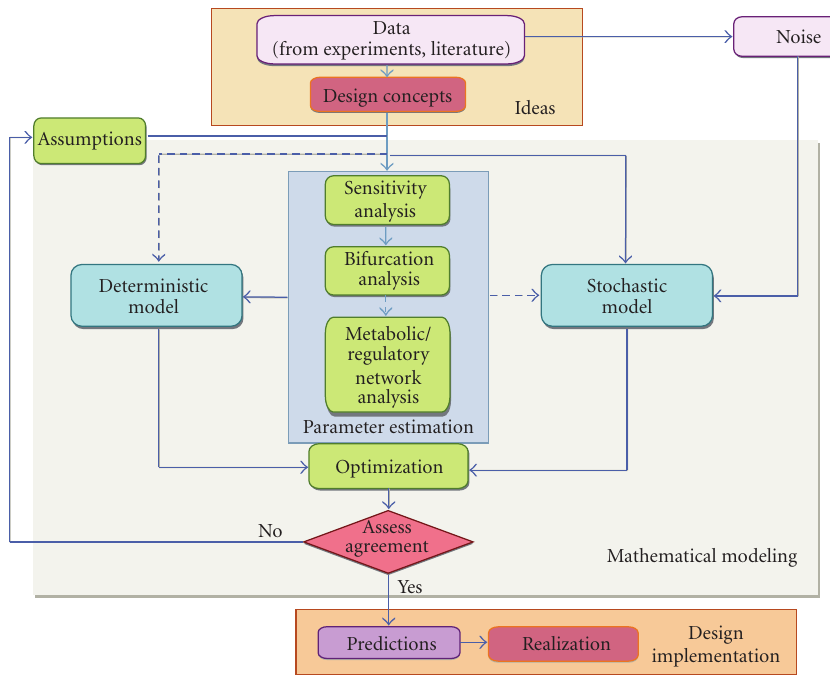
Figure 1: The role of mathematical modeling in synthetic biology. Computer-aided mathematical modeling bridges a design concept to realization in synthetic biology. Solid lines depict typical steps that have to be performed while developing a model; dashed lines depict unusual scenarios or conditions under which the steps shown by the corresponding solid lines are trivial or can be bypassed. A concept or ideas for designing a circuit for a particular function may be inspired by data from experiments or the literature. A mathematical model is then formulated on the basis of certain assumptions. The framework of a model could be deterministic or stochastic. The development of a model generally begins with the estimation of parameters that govern the model; this is a process that involves sensitivity analysis, bifurcation analysis, and, under certain circumstances, metabolic and transcription (regulatory) network analysis. The dashed line from design concepts to deterministic model indicates that, in some cases, parameter estimation is trivial or can be bypassed for this type of model. A stochastic model is developed by employing statistical functions to mimic system dynamics and considering fluctuations in the data. The dashed line from parameter estimation to stochastic model indicates that in some cases, parameter estimation may o ff er information in choosing statistical functions when constructing a stochastic model. Optimization is required for both models and is complete when the model exhibits an agreement (goodness of fit) with experimental data. A good agreement enables reliable prediction of system behavior and further biological realization, whereas unsatisfactory agreement requires the revision of the initial assumptions and the beginning of the next modeling cycle. See text and Figure 2 for explanations of